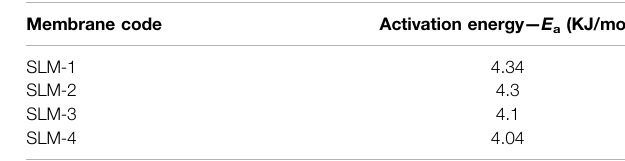
TABLE 5 | Activation energies of the PDES-SLMs.